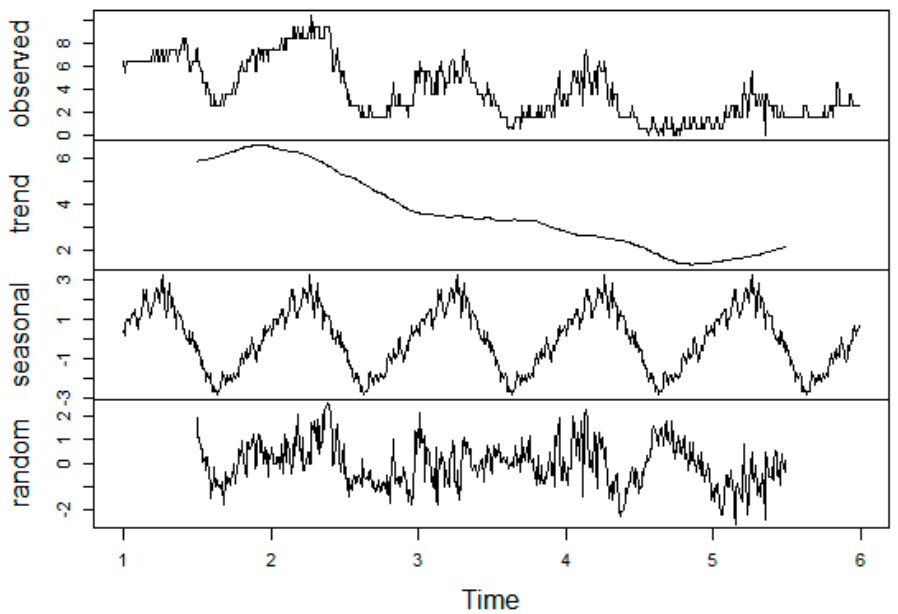
Figure 4. Decomposition of additive time series. Table 3. Characteristic values of the sinusoidal curve at different setpoint temperatures. LSS: least squares setting; FFT: fast Fourier transform.